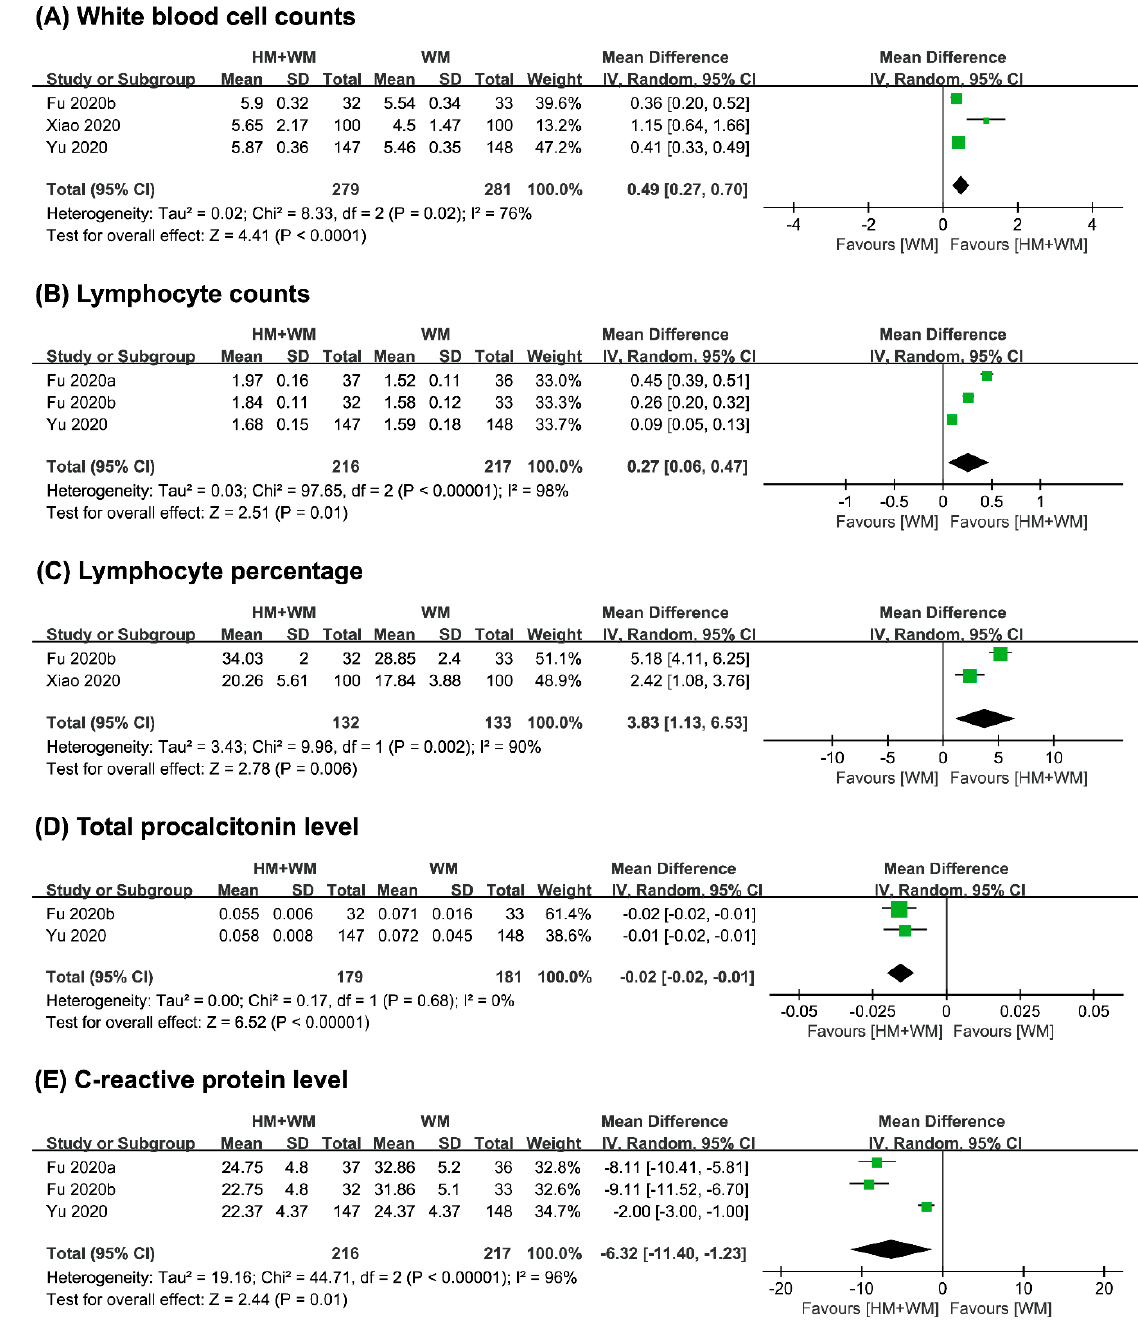
Figure 5. Comparison of herbal medicine and Western medicine (HM + WM) vs. Western medicine (WM) on ( A ) white blood cell counts (10 9 cells/L); ( B ) lymphocyte counts (10 9 cells/L); ( C ) lymphocyte counts percentage; ( D ) total procalcitonin level (ng/L); ( E ) C-reactive protein (mg/L).